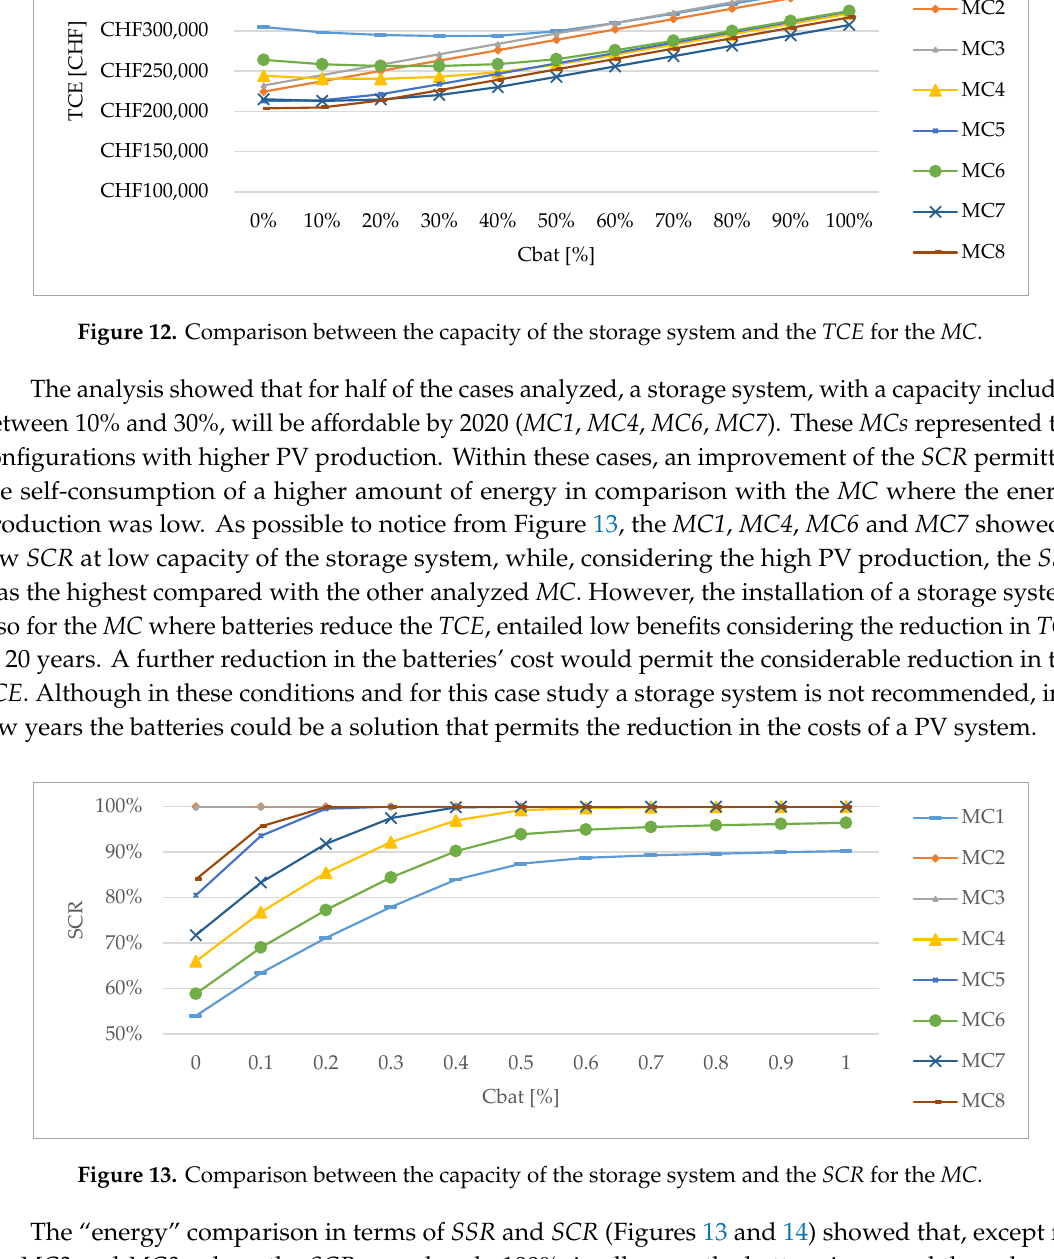
Figure 13. Comparison between the capacity of the storage system and the SCR for the MC.